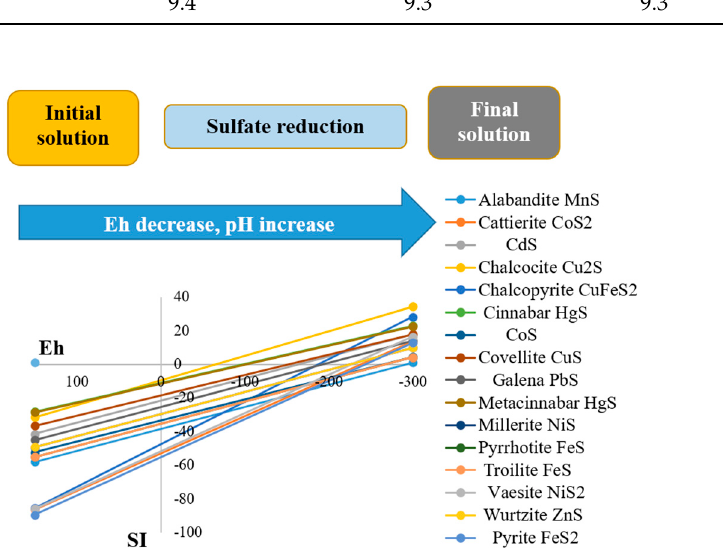
Figure 4. Kinetics of eH and Fe and S О 4–2 concentration change in solutions in biomineralization experiment.